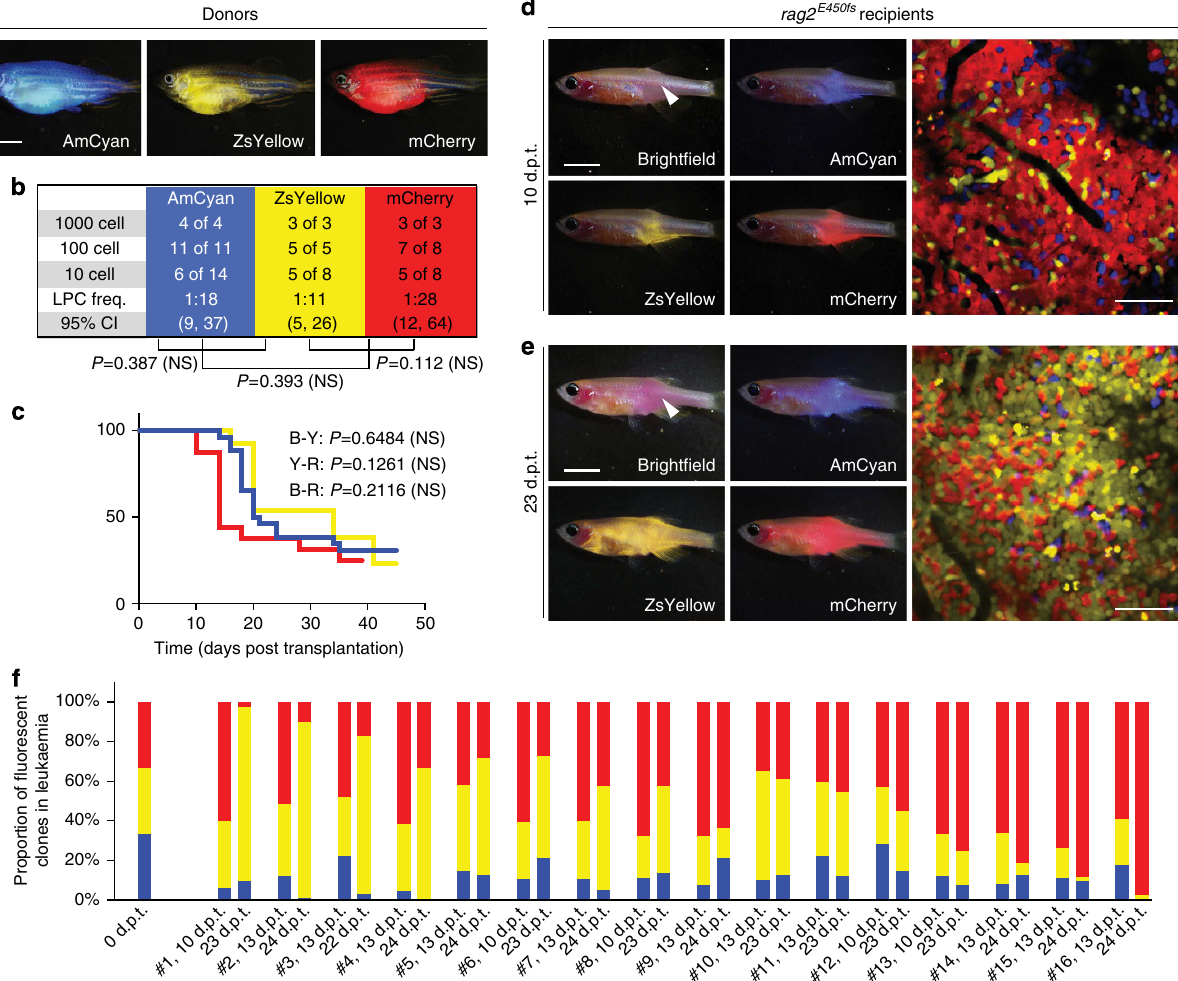
Figure 4 | Visualizing the emergence of clonal dominance in Myc-induced T-ALL. ( a ) Donor animals engrafted with monoclonal T-ALL arising in the CG1 background. ( b , c ) Monoclonal T-ALLs were implanted into the syngeneic CG1 strain fish and assessed for LPC frequency by limiting dilution cell transplantation ( b ) or latency of regrowth ( c ). P -values are noted within each panel. Not significant (NS). ( d , e ) Confocal imaging of engrafted rag2 E450fs (casper) fish at 10 d.p.t. ( d ) and 23 d.p.t. ( e ). White arrow denotes site of injection, and the location for confocal imaging. ( f ) Relative proportions of each fluorescent clone contained within leukaemias from individual engrafted animals ( n ¼ 16 animals). Imaging was completed on the same animals at